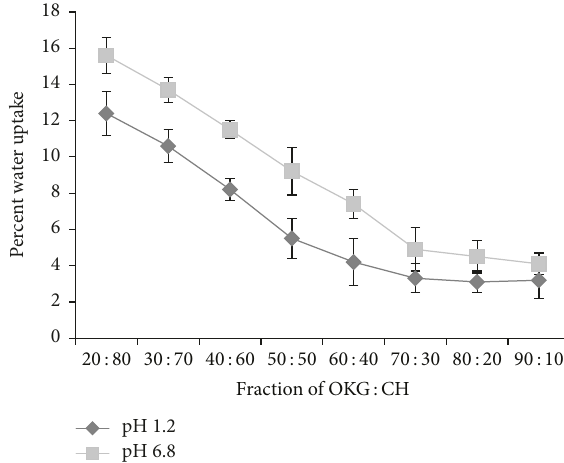
Figure 5: Effect of different ratios on percent water uptake by the PECs.